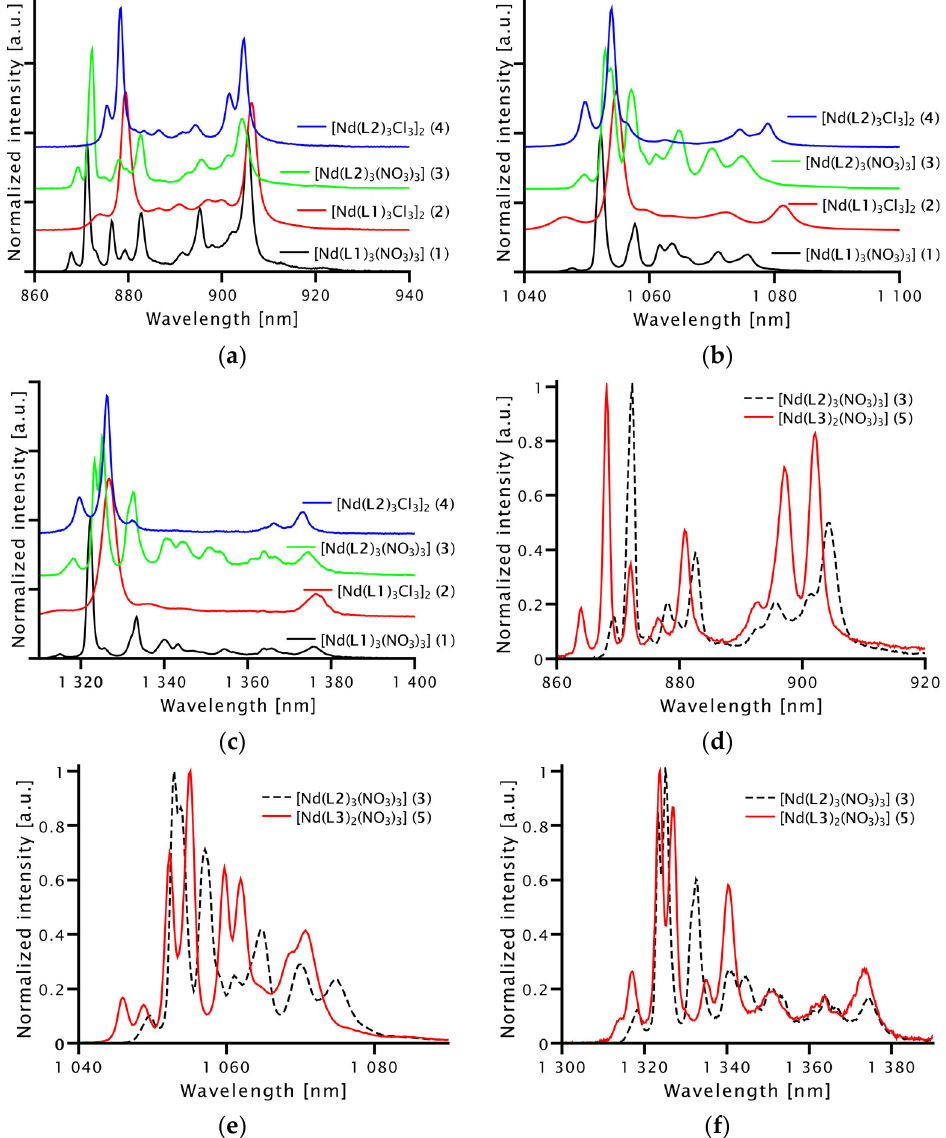
Figure 8. The normalized low-temperature (5 K) PL spectra of amorphous bulk [Nd( L1 ) 3 (NO 3 ) 3 ] ( 1 ) (black), [Nd( L1 ) 3 Cl 3 ] 2 ( 2 ) (red), [Nd( L2 ) 3 (NO 3 ) 3 ] ( 3 ) (green), and [Nd( L2 ) 3 Cl 3 ] 2 ( 4 ) (blue) for the 4 F 3/2 → 4 I 9/2 ( a ), 4 F 3/2 → 4 I 11/2 ( b ), and 4 F 3/2 → 4 I 13/2 ( c ) transitions, respectively. ( d – f ) Low-temperature (5 K) PL spectra of mono-phosphonate ester-supported compound [Nd( L2 ) 3 (NO 3 ) 3 ] ( 3 ) (dashed line) and geminal bisphosphonate ester complex [Nd( L3 ) 2 (NO 3 ) 3 ] ( 5 ) (solid line) for the three different emission bands.